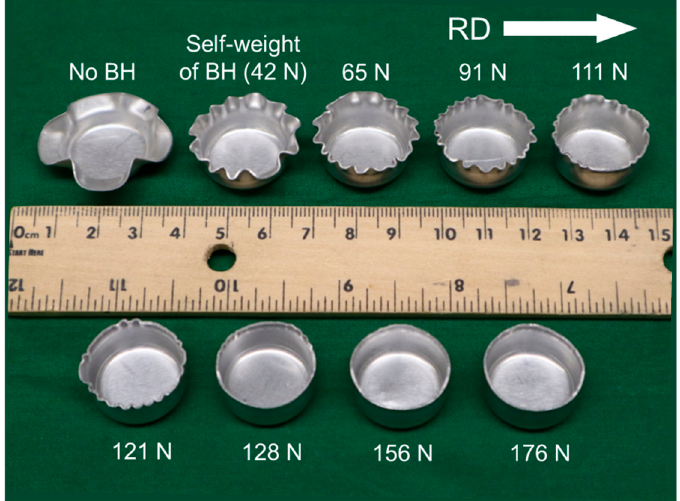
Figure 4. Aluminum AA1100-O cups (diameter 35 mm, thickness 0.51 mm) drawn under a set of BHFs ranging from zero to 176 N. Indicated in the figure is the rolling direction, RD.